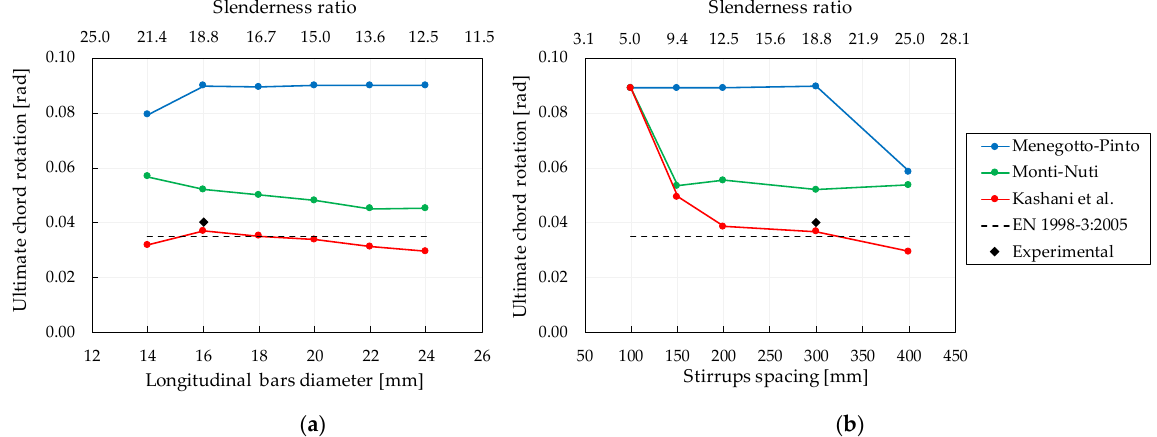
Figure 8. Comparison of ultimate chord rotation for different values of: ( a ) longitudinal bars diameter, φ, ( b ) stirrups spacing, s.